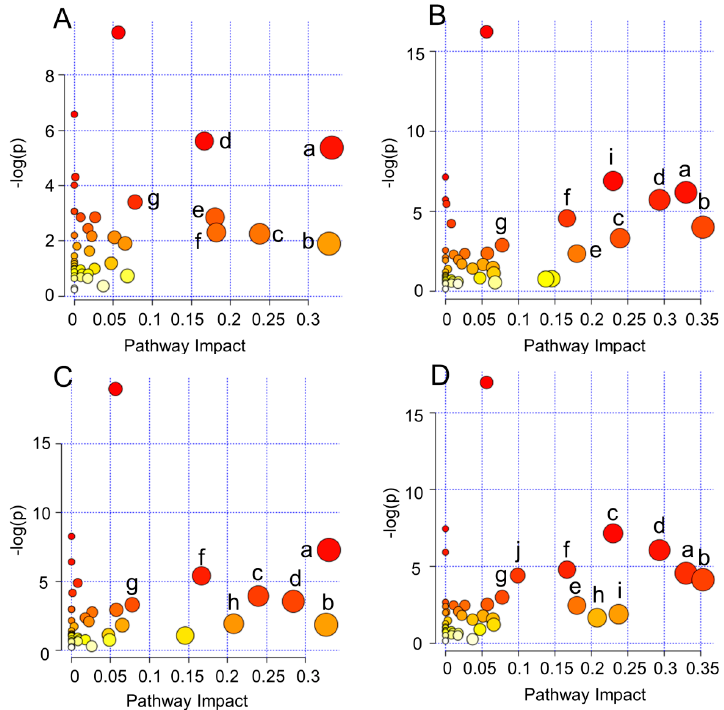
Figure 5. Global metabolic pathways affected by metalaxyl enantiomers based on MetaboAnalyst 3.0. ( A ) S -metalaxyl (10 µM); ( B ) R -metalaxyl (10 µM); ( C ) S -metalaxyl (50 µM); ( D ) R -metalaxyl (50 µM).